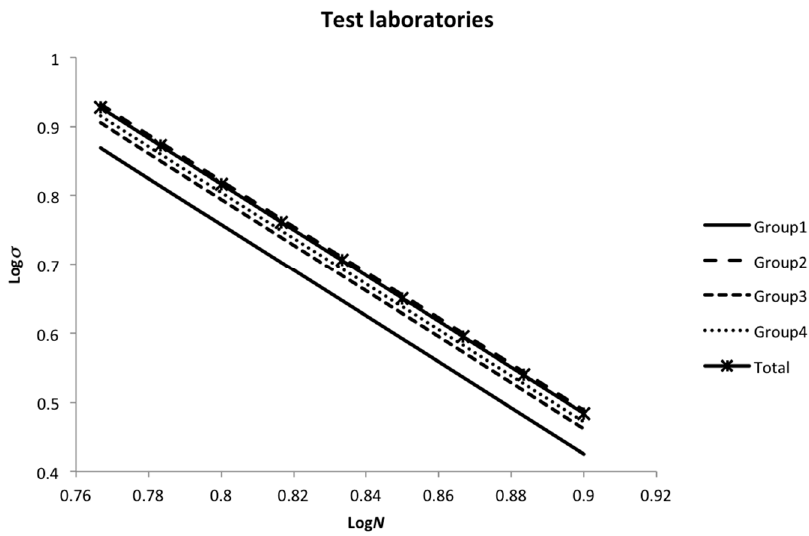
Figure 2. Comparison of “testing laboratories” on logarithmic scale.